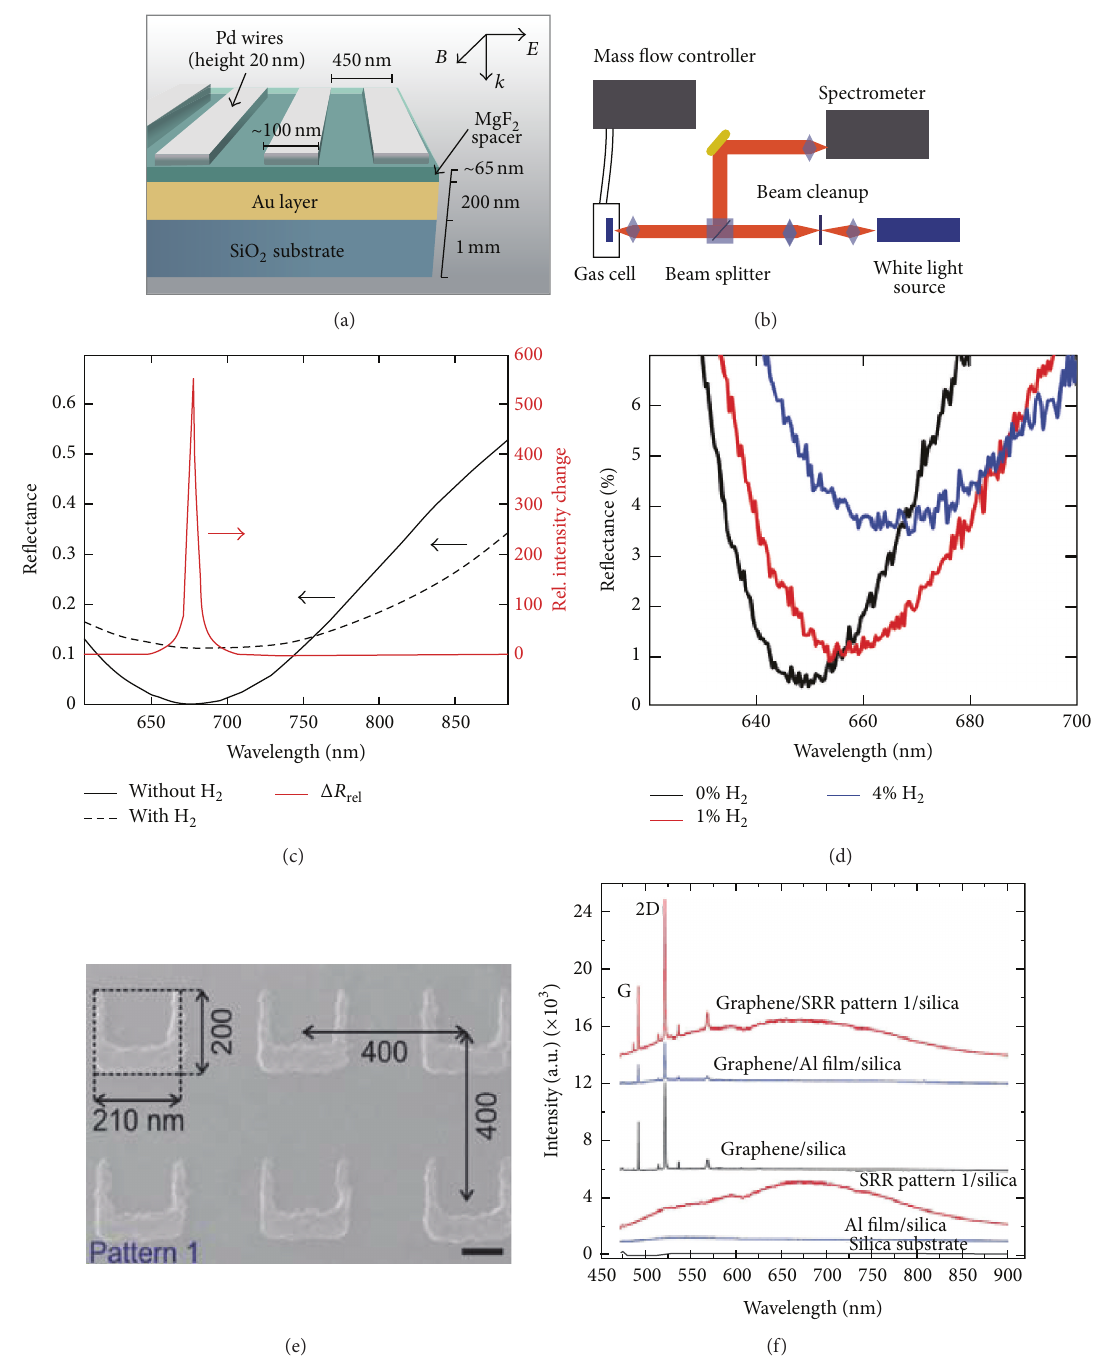
Figure 26: (a) A side view of the sensor. Palladium nanowires are stacked above a gold mirror. The layers are separated by a MgF2 film. (b) A sketch of the experimental setup including the mass flow controllers used to set the desired hydrogen concentrations. (c) Simulated response of the sensor structure to hydrogen exposure. (d) Reflectance of the absorber for different hydrogen concentrations. (e) SEM images of split ring resonators (SRRs) on a graphene layer. (f) Experimental results of the Raman spectra for different conditions. Figures are reproduced from (a)–(d) [149] and (e, f)